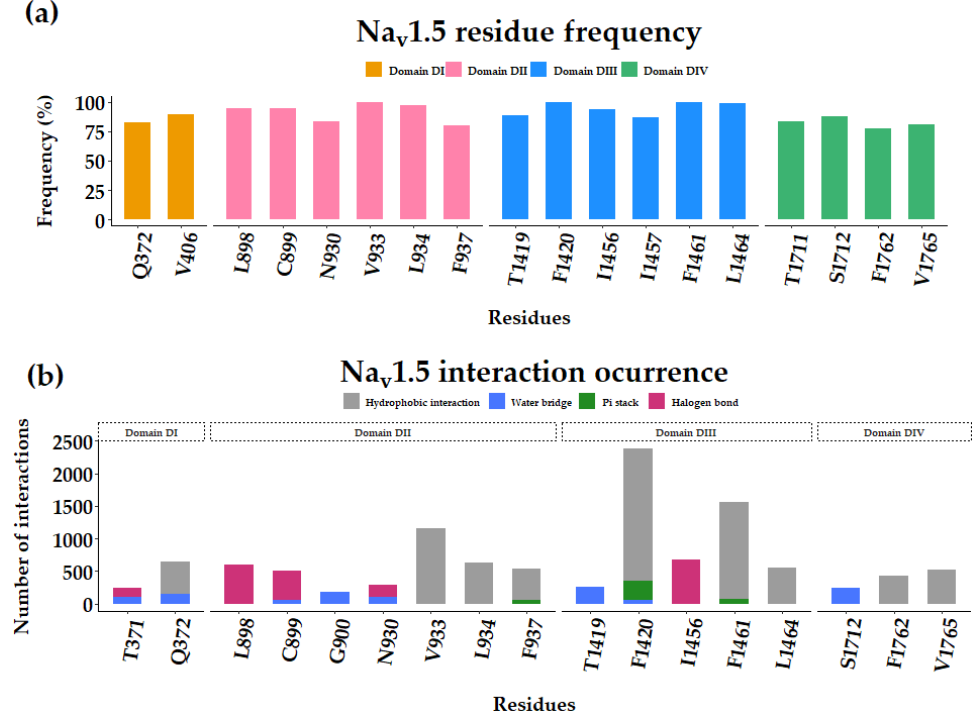
Figure 4. Flecainide interactions in Na v 1.5 along MD simulations . The residue contacts and interactions were computed along the 100 ns MD simulations. ( a ) Residues in contact within 5 Å of flecainide with a frequency of ≥70%. ( b ) Residues interacting with flecainide and the nature of such interactions were predicted using PLIP software. Only the residues with number of interactions ≥ 20% of the maximum value of its type are considered.